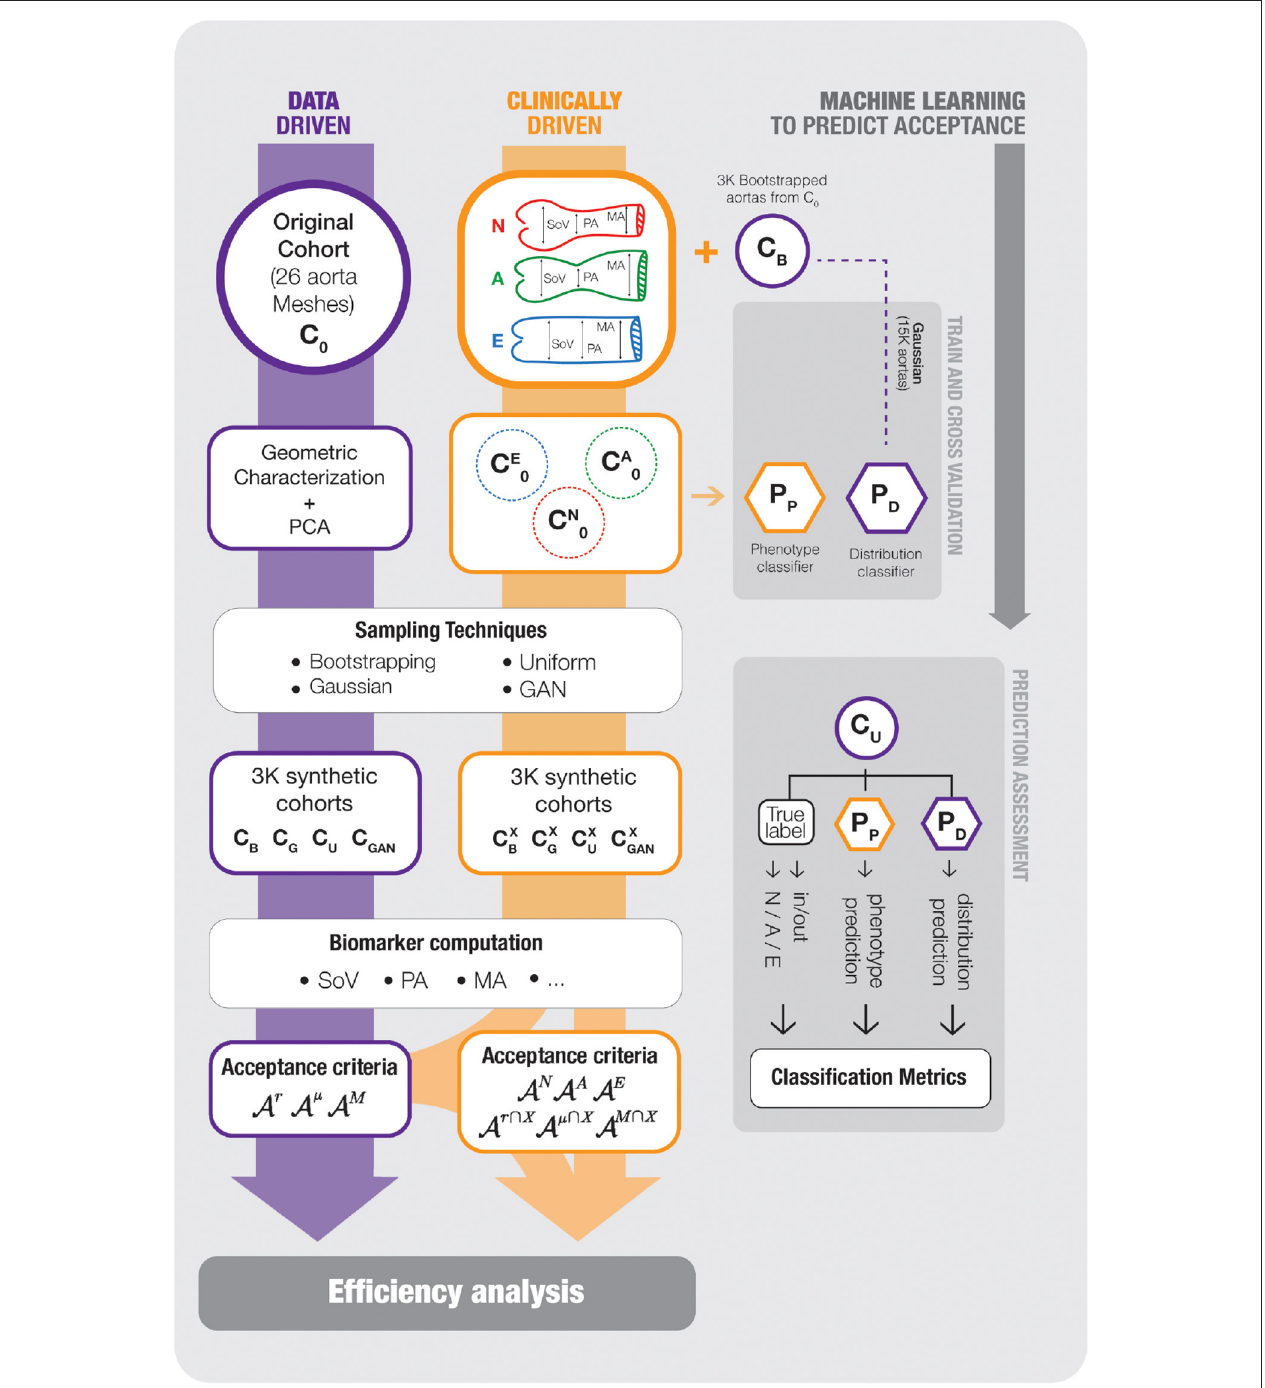
FIGURE 3 | An scheme of the workflow followed in our experimental setup. On the left track, the data-driven cohort generation scenario is shown; the reference cohort C 0 , that is characterized using PCA to generate new samples C B , C G , C U , and C GAN , which are assessed with the acceptance functions A X . The middle track, representing the clinically-driven experiments, starts splitting the samples of the boostrapping cohort, C B , generated on the previous scenario, onto the three target phenotypes, N , A and E and, then, new cohorts C X B , C X G , C X U and C X GAN are generated and, again, assessed by the corresponding acceptance functions A X . Finally the rightmost blocks represents the development of Machine Learning surrogates to predict the acceptance functions. The synthetic cohort C B is used to train two SVM models, P p and P µ d ( P D in the chart), that predict the outcome of A µ and the aorta phenotype, respectively. The models are evaluated with C U , that was not used during training. For any item of the picture, a purple frame means data-driven and an orange frame means clinically-driven. The reader can refer to the text for further